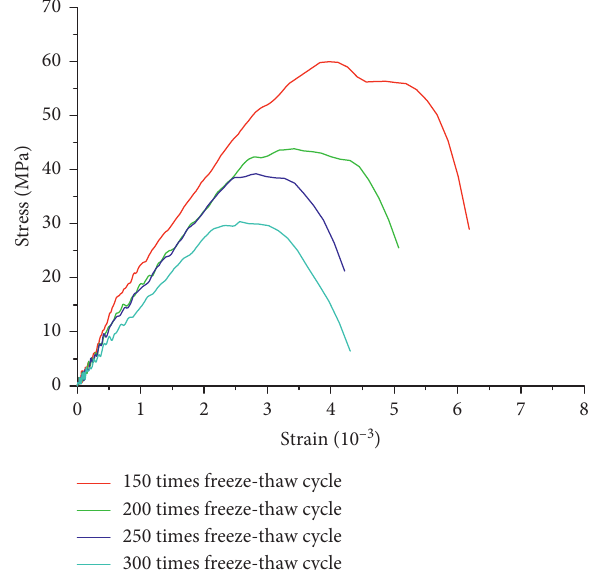
Figure 12: Stress-strain curve of different freeze-thaw cycles.